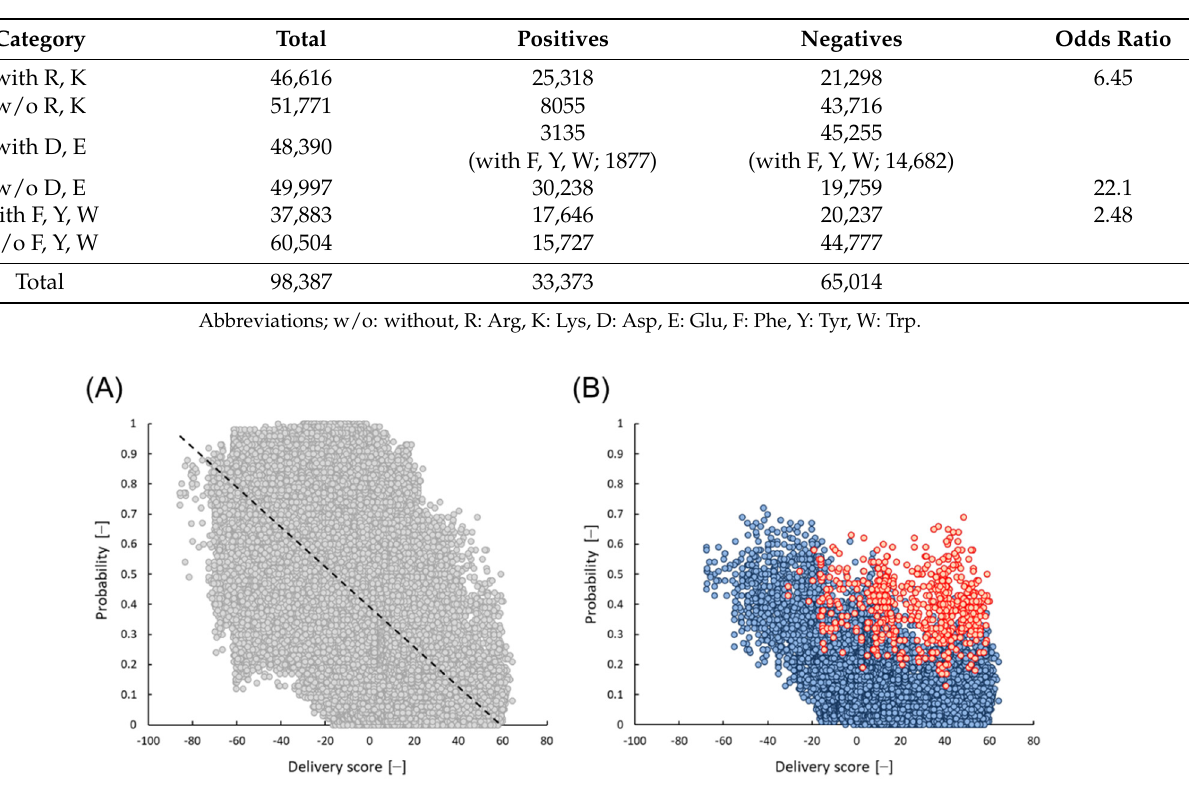
Figure 6. Relationship between the probability of RF model and the predicted delivery score on the 6-mer edible peptides derived from storage proteins. ( A ) Total 98,387 peptides (gray dots, a dashed line means a least square approximate straight line), ( B ) 15,609 peptides containing more than two residues of acidic amino acid such as D (Asp) or E (Glu) (blue dots), and 589 peptides additionally containing more than two residues of aromatic amino acids such as F (Phe), Y (Tyr), or W (Trp) (red dots).